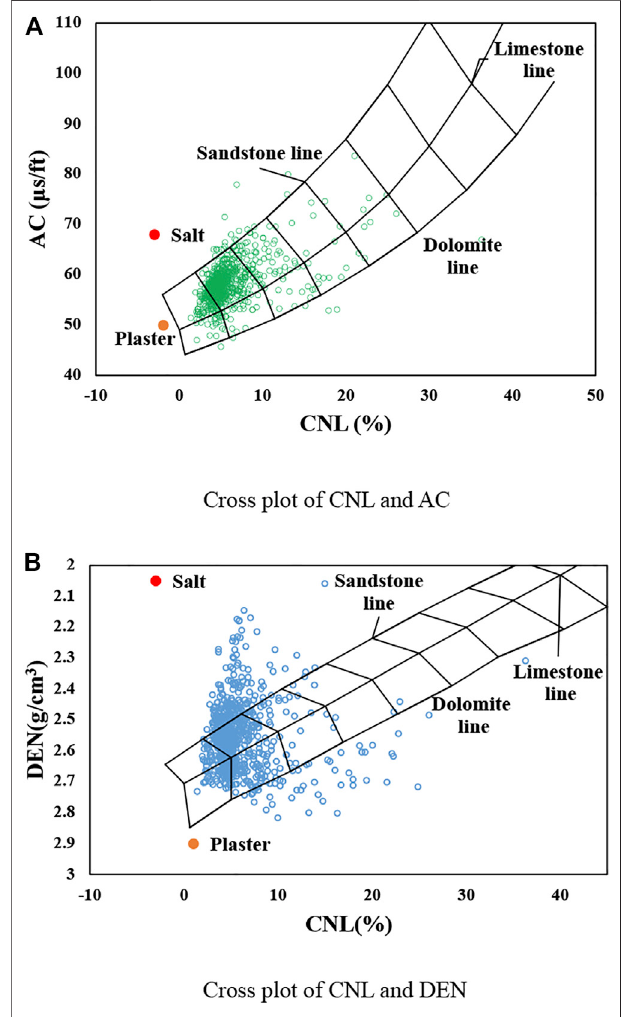
FIGURE4| Crossplotofporosity log. (A) CrossplotofCNLandAC. (B) Cross plot of CNL and